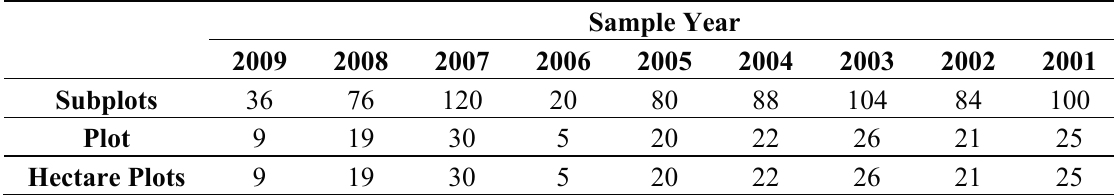
Table 1. Total number of Forest Inventory and Analysis subplots, plots, and hectare plots by